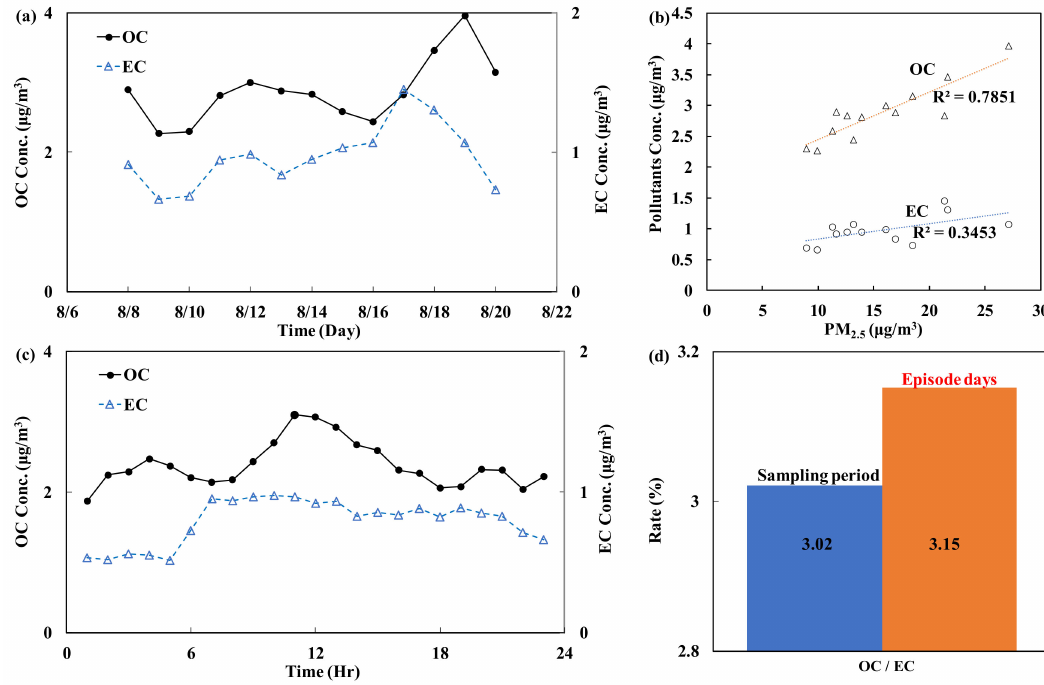
Figure 7. Carbon concentrations during the monitoring period: ( a ) daily average trend; ( b ) correlations between OC and PM 2.5 and between EC and PM 2.5 ; ( c ) hourly average trend; and ( d ) OC/EC